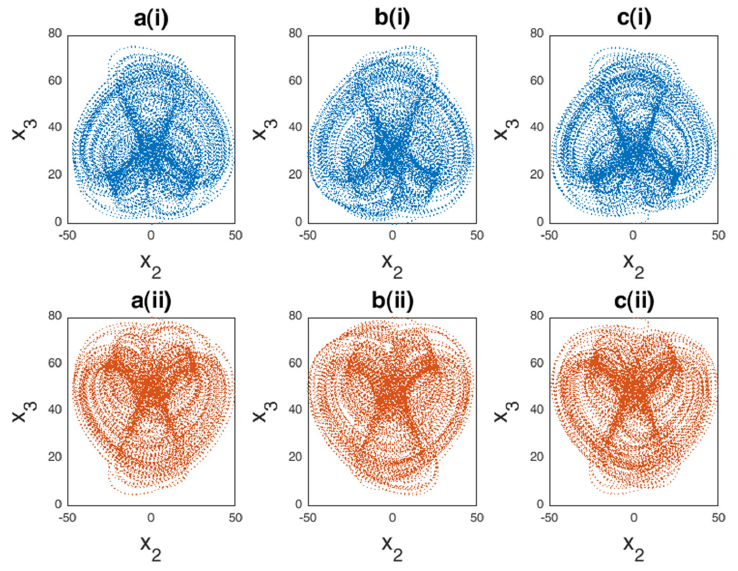
Figure 1. Phase portrait diagrams of the new hyper-chaotic system on the x 2 − x 3 space for different initial conditions: ( a ) [ − 0.01, − 0.1, − 0.01, − 0.1, − 0.01, − 2.5], ( b ) [ − 0.1, − 0.1, − 0.1, − 2.5, − 0.1, − 0.1] and ( c ) [ − 0.1, − 0.1, − 0.1, − 0.1, − 0.1, − 2.5]